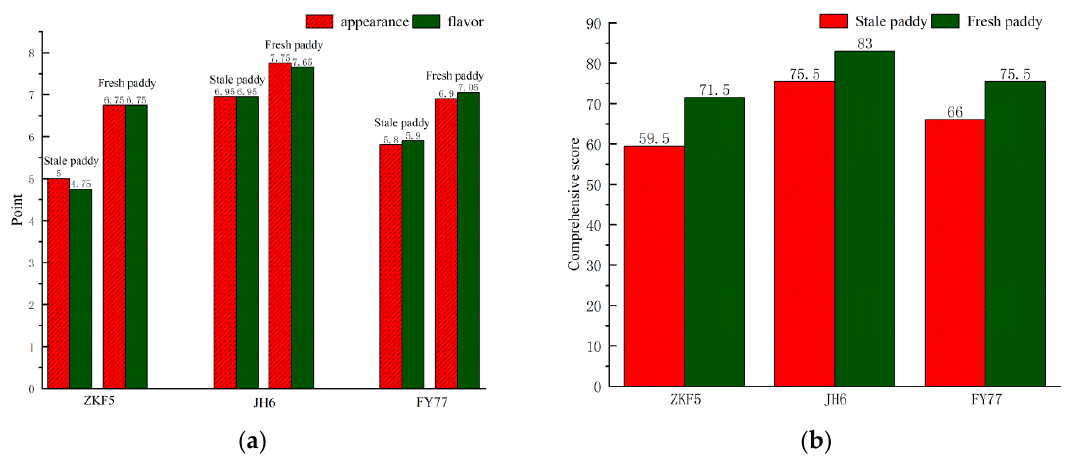
Figure 10. Comparison of palatability between fresh rice and rice stored for one year: ( a ) comparison of scores for appearance and flavour; ( b ) comparison of comprehensive scores.